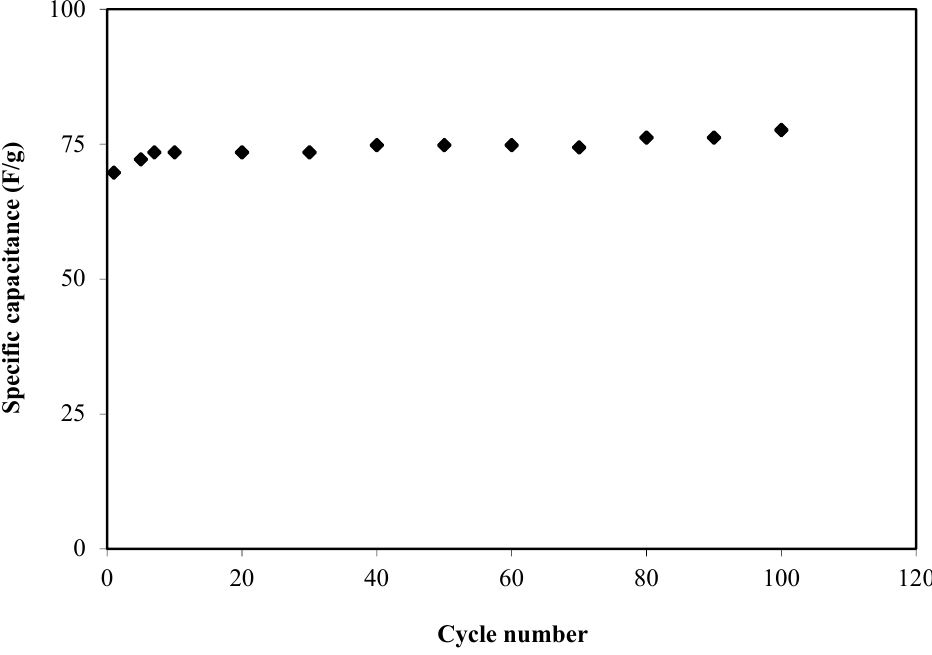
Figure 7. Specific capacitance ( C s ) of the fabricated EDLC for 100 cycles.